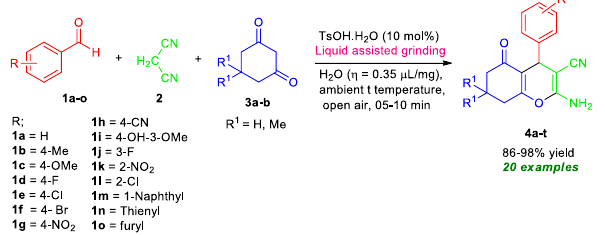
Figure 5. Synthesis of 2-amino-3-cyano-4 H -chromenes 4 under the standard